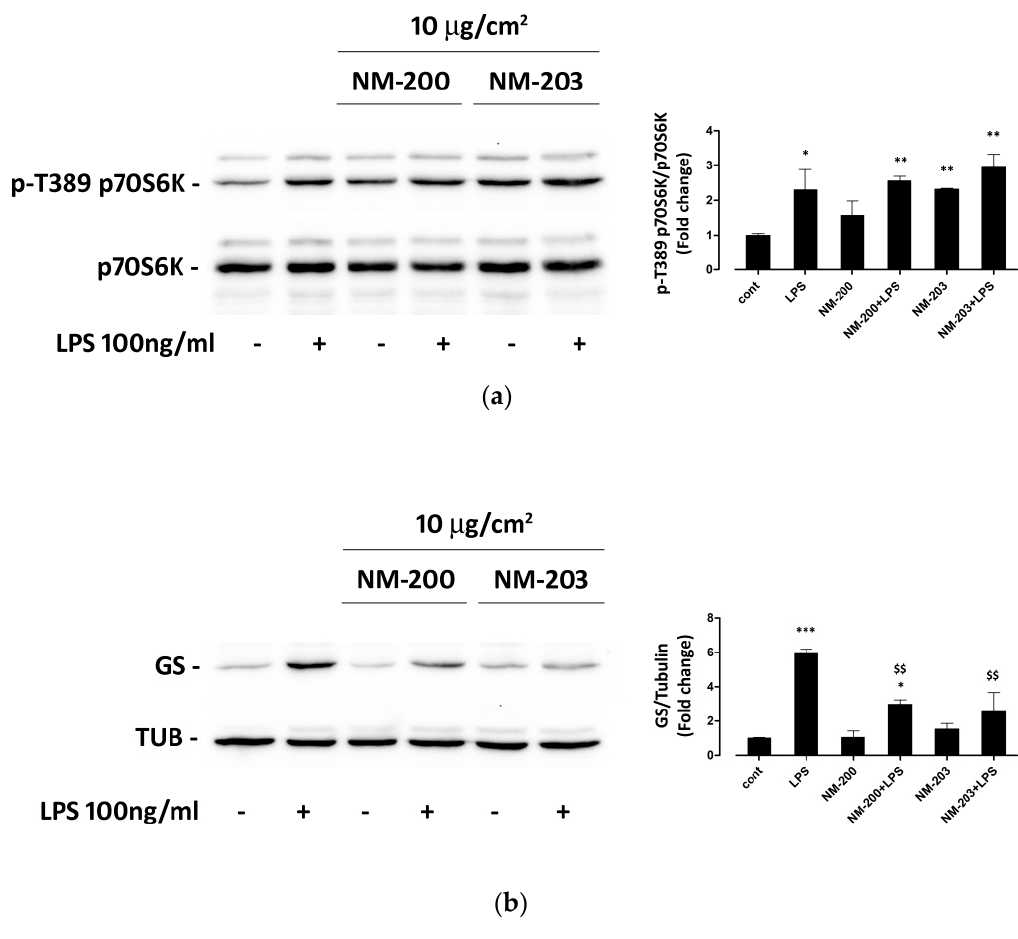
Figure 3. Effects of ASNPs on the mTORC1 activity and GS expression. THP-1 cells were treated as described above for Figure 2b. At the end of the experimental treatments, the expression of the indicated proteins was assessed. Bars report the means of the relative abundance of p-T389 pP70S6K vs. total pP70S6K ( a ) and GS vs. tubulin ( b ) ± SD (n = 3). * p < 0.05; ** p < 0.01; *** p < 0.001 vs untreated cells; $$ p < 0.01 vs LPS, one-way ANOVA.